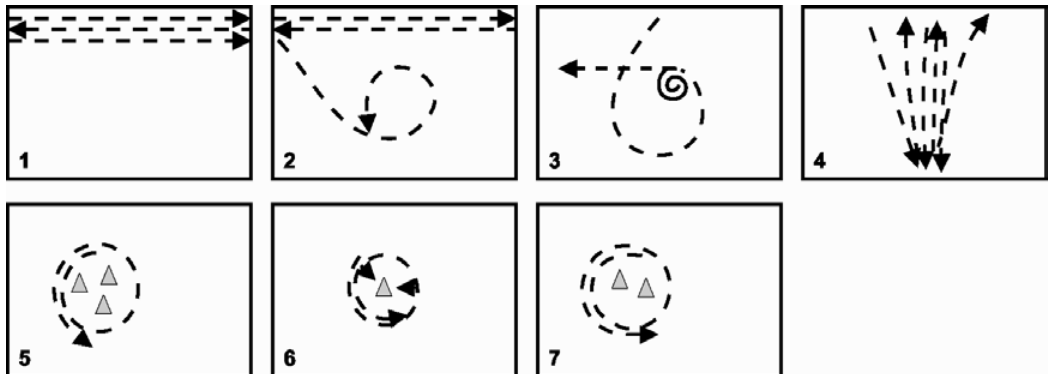
Figura 1. Representação esquemática do episódio das